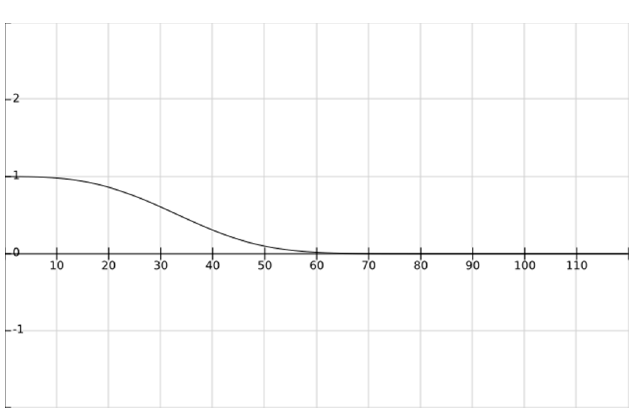
Figure 8. Representation of the memory management function proposed for a time of 3600 s ( ƺ = 3600).